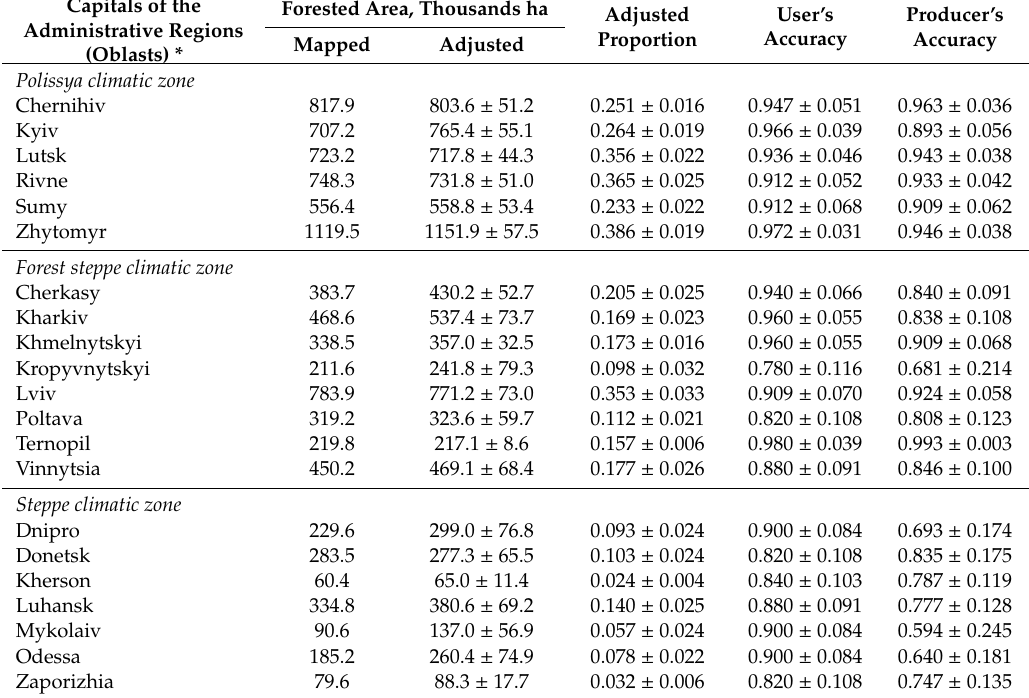
Table 5. Regional estimates of Landsat-derived forested area in flatland Ukraine (at 95% confidence